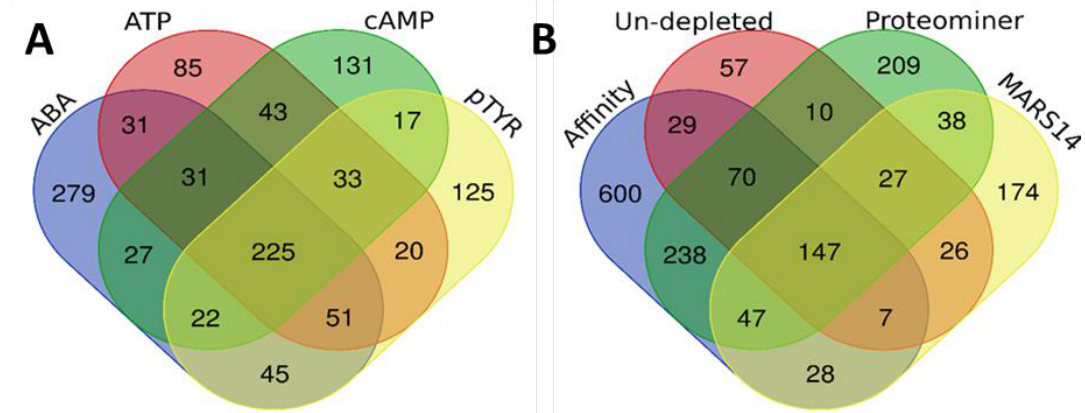
Figure 3. Unique and shared proteins identified in ( A ) samples enriched for low-abundant proteins using the affinity-based probes pTYR, ABA, ATP, or cAMP, and in ( B ) un-depleted plasma samples, plasma samples depleted for high abundant proteins using the MARS14 depletion column, the Proteominer protein equalization method, and the sum of proteins identified as identified in ( A ).